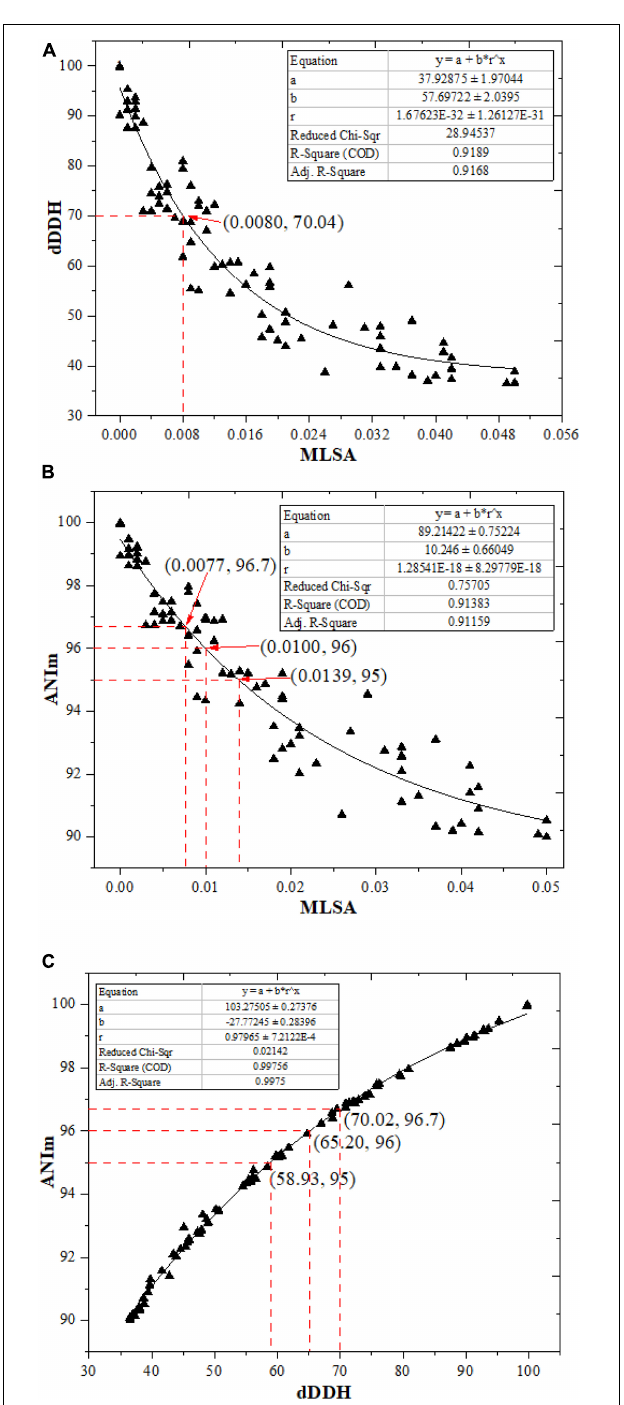
FIGURE 1 | The correlations between ANIm, dDDH, and MLSA from the 80 pairs of Streptomyces species (including heterotypic synonyms).